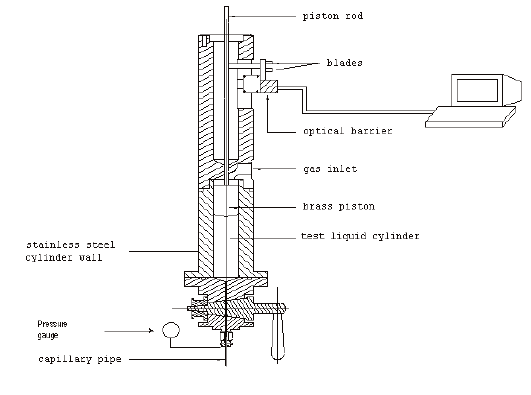
Figure 2 (left): Drainage curves of foams at different PEO concentrations. Figure 3 (right): Capillary tube